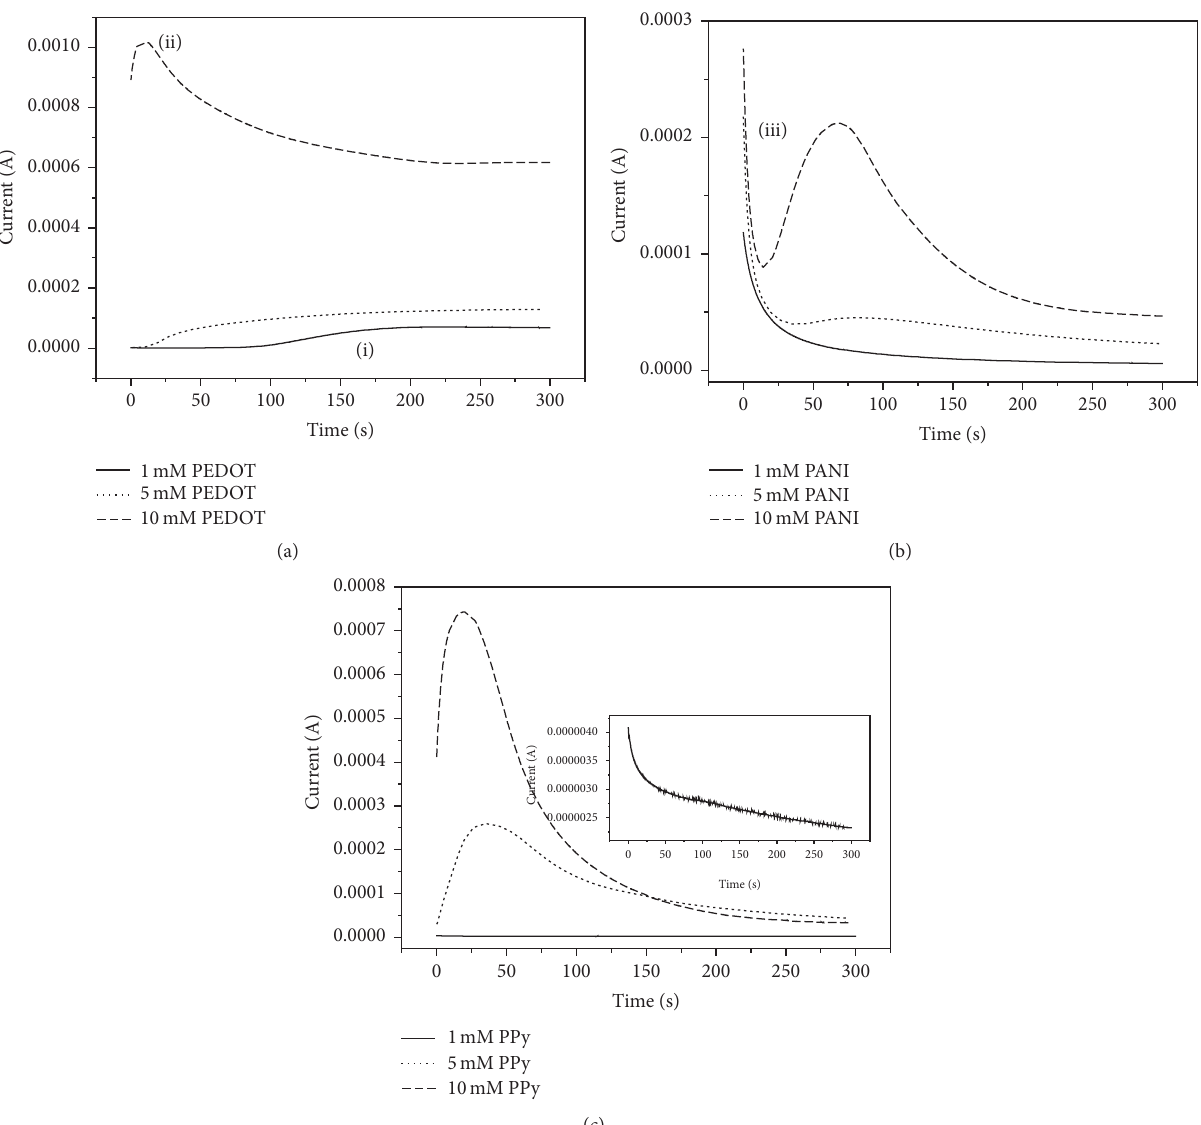
Figure 2: Chronoamperograms of (a) PEDOT, (b) PANI, and (c) PPy films electropolymerized on ITO substrate prepared from 1mM, 5mM, and 10mM monomer in 0.1M LiClO 4 at 1.0 V. Inset: (c) magnification of chronoamperogram of PPy prepared from 1mM